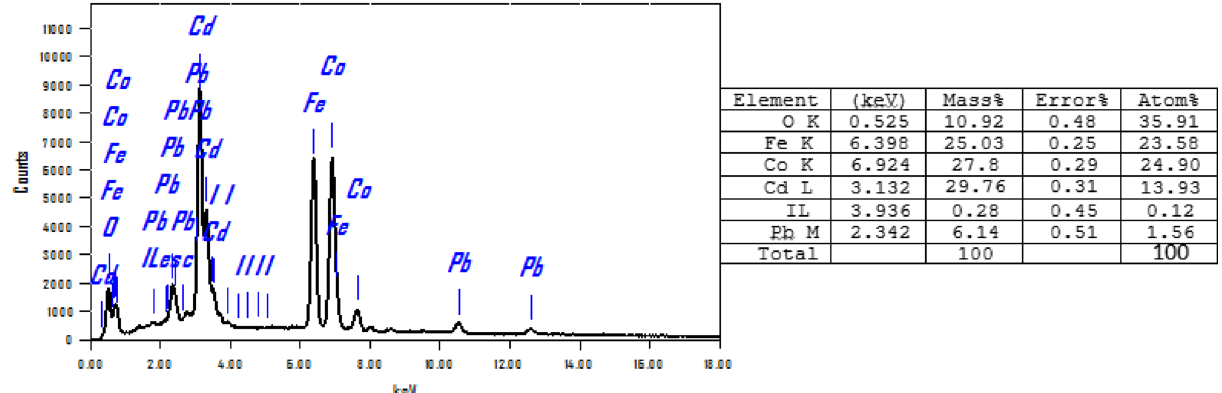
Figure 10. EDX of TLDH/PbI 2 NC after ten runs in KOH electrolyte for H 2